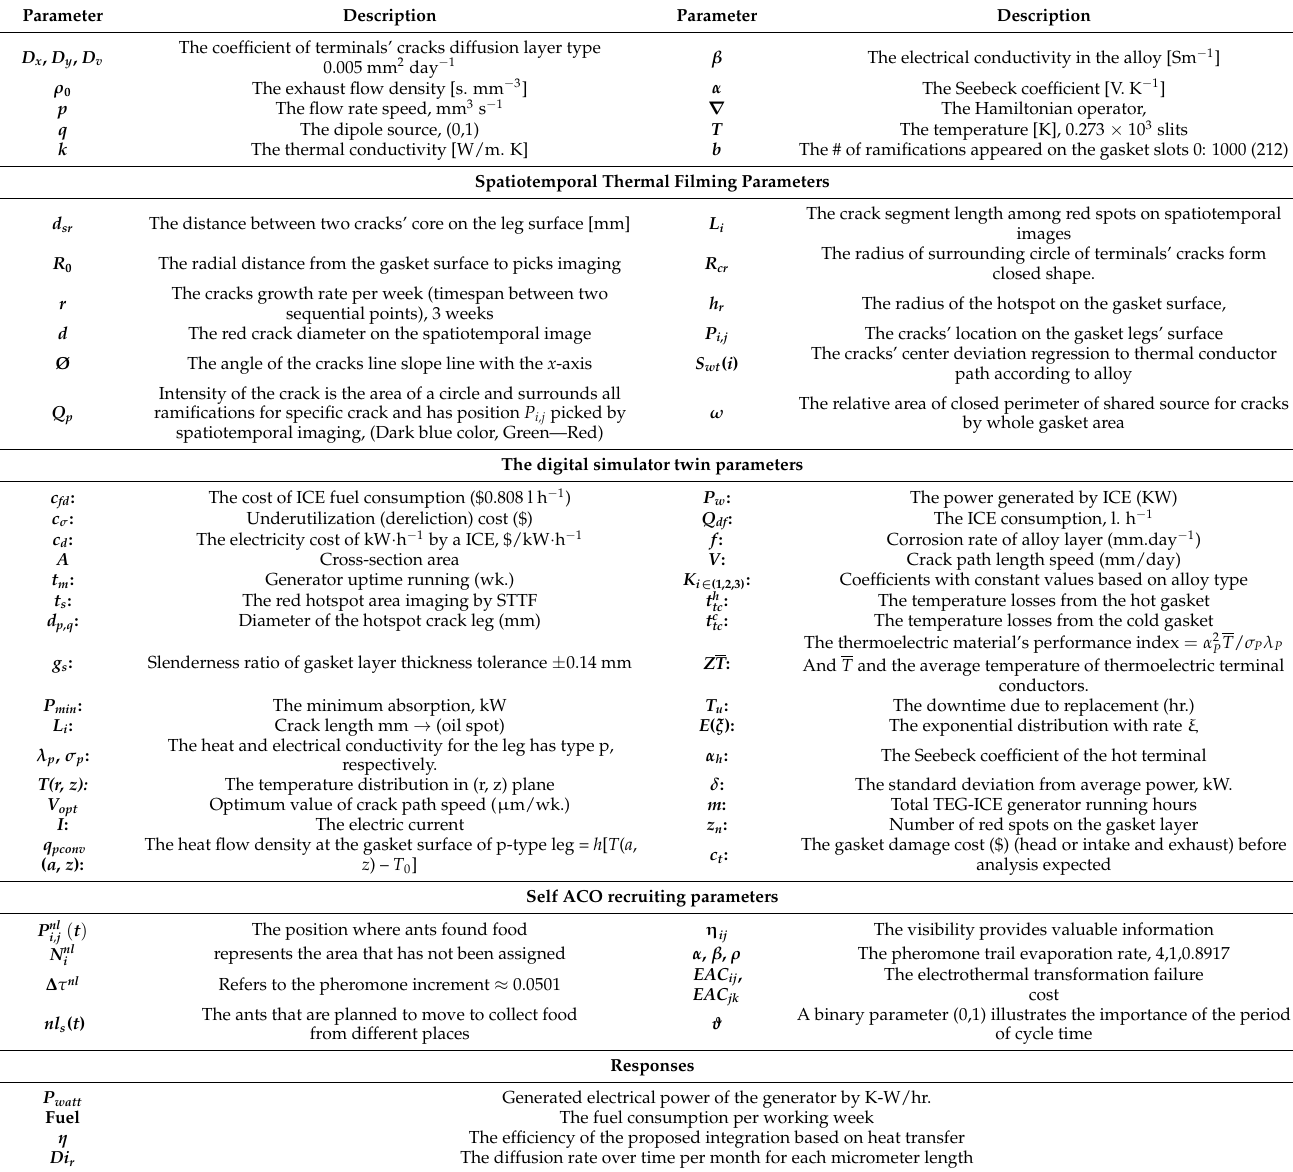
Table 2. The ideal parameters and objective for proposed digital twin